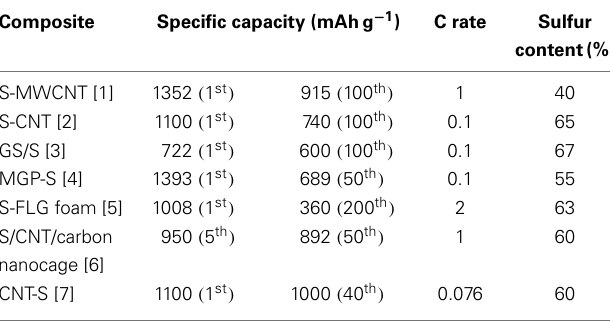
Table 1 | Comparison of electrochemical performance of different sulfur composite